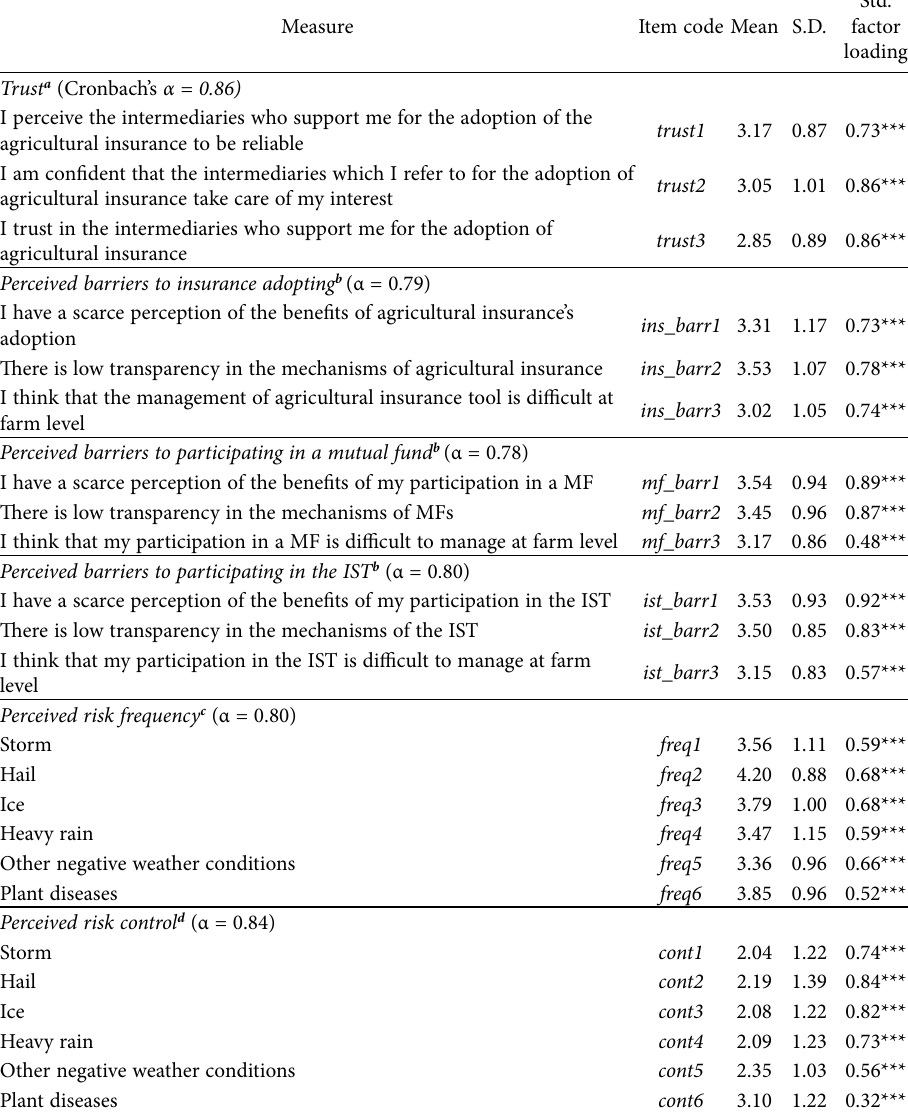
Measure Item code Mean